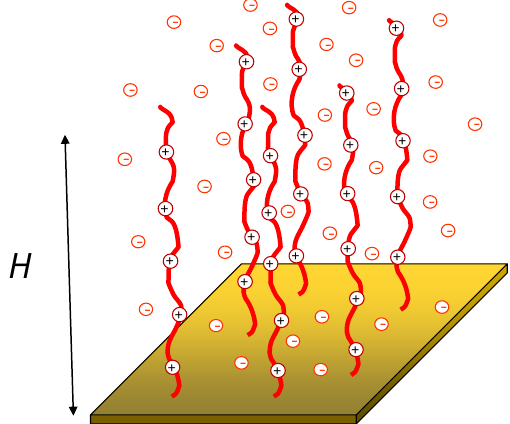
Figure 1. Schematics of a polyelectrolyte brush. N is the number of monomer units per chain, α -fraction of (positively) charged monomer uits, s -surface area per chain, H -brush thickness. Counterions localized predominantly inside the brush are